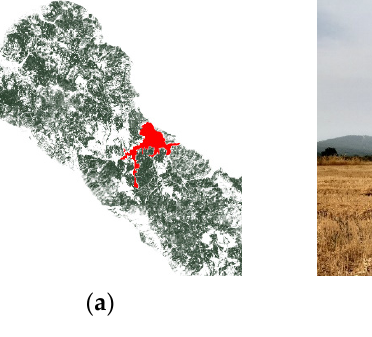
Figure 19. Τ he flatland of Krya Vrisi (center of the figure). The area of the fire (left), forests un ‐ touched by the fire (right). Map form Google Earth [73]. . 6.2. Local Communities and the Forest Before the fire, about 580 families in north Euboea exploited the forest collecting resin, and about 80 families were working in logging. Others were beekeepers or had olive trees. It is estimated that 50% of the Greek production of resin (3000 tons per year) and 65% (10,000 tons per year) of the Greek production of pine tree honey were lost. In addi ‐ tion, 9000 beehives were destroyed or suffered severe damage [86–89]. Examining the livestock and the beehives of the area (Figure 20), we see that about 88% of these activities rely on the forest. Even the coops were out of villages, inside the forest, and many of them were burnt. It is clear that the forest constitutes wealth for the local community, and hence its destruction is an economic disaster for the community, even for inhabitants whose prop ‐ erties were not affected by the fire.